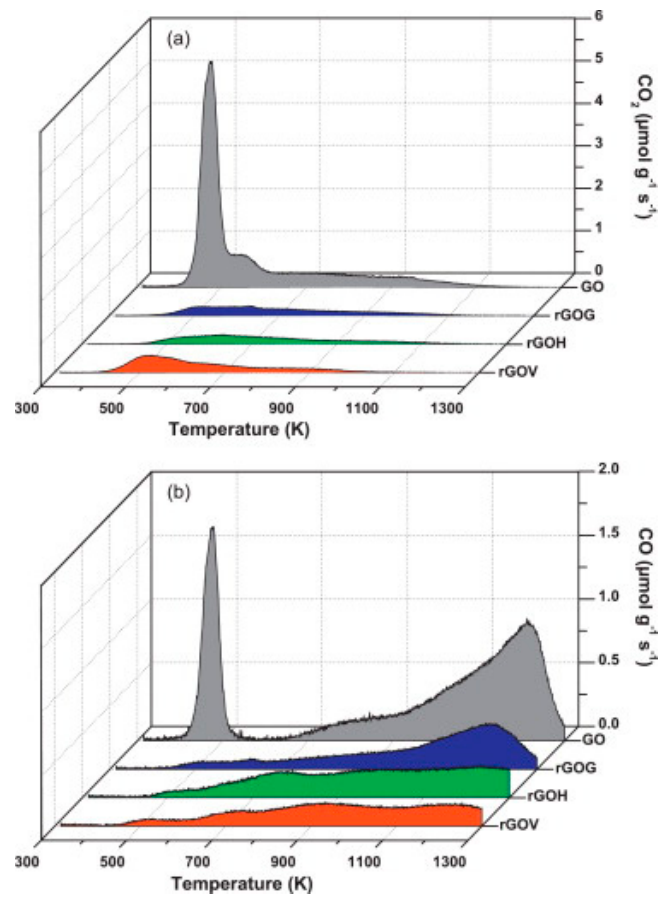
Figure 27. TPD profiles for the release of CO 2 ( a ) and CO ( b ) from GO and reduced GO using glucose (GOG), hydrazine (GOH) and ascorbic acid (GOV). Reprinted with permission from reference [158]. Copyright 2014 Elsevier.